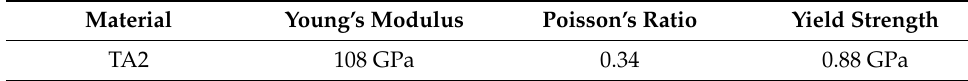
Table 1. Constitutive parameters of simulated